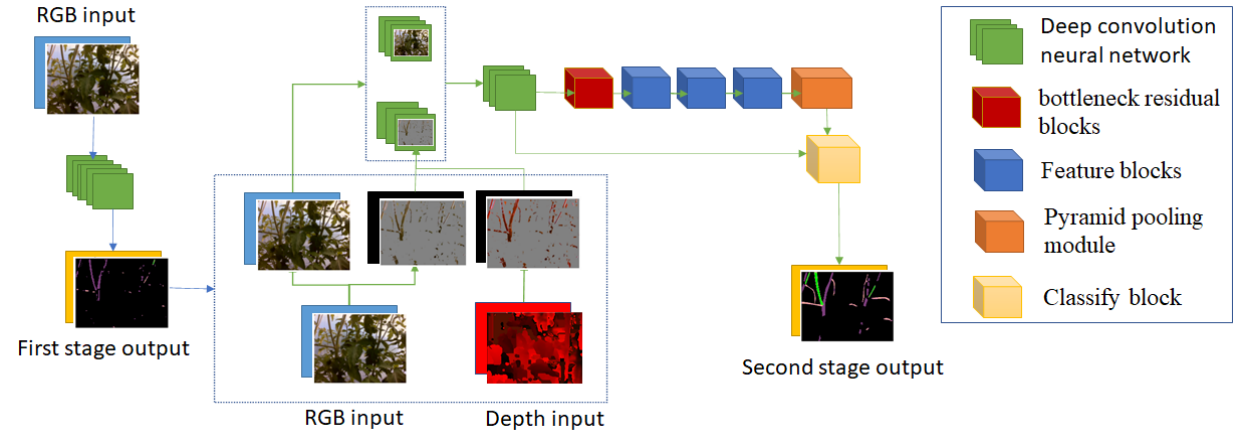
Figure 7. Structure of proposed semantic segmentation neural network.